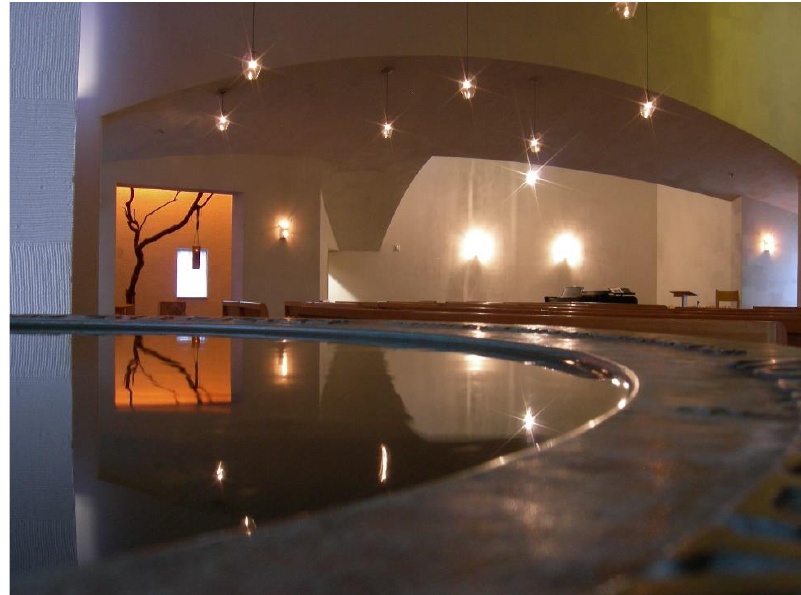
Figure 10. The interior of the St Ignatius Chapel, Seattle